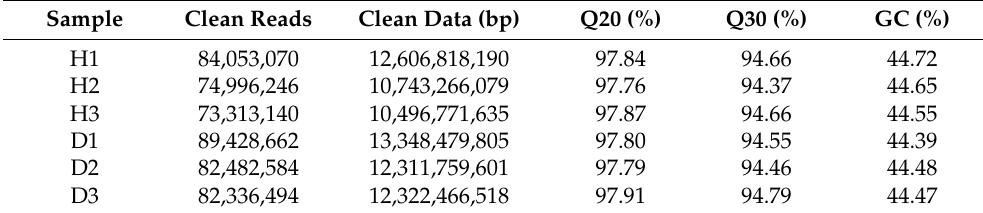
Figure 1. Comparison of morphology, growth, photosynthesis and flavonoid content of haploids and diploids. Schemes follow the same formatting. ( A ) Leaf area. ( B ) The net photosynthetic rate of the leaves. ( C ) Leaf flavonoid content. ( D ) Haploid and diploid leaf morphology. Bars with different letters indicate significant differences at p < 0.05 according to Duncan’s test; 1 × : haploid plants; 2 × : diploid plants. Bar = 1 cm. Table 1. An overview of the sequencing quality of six ginkgo RNA